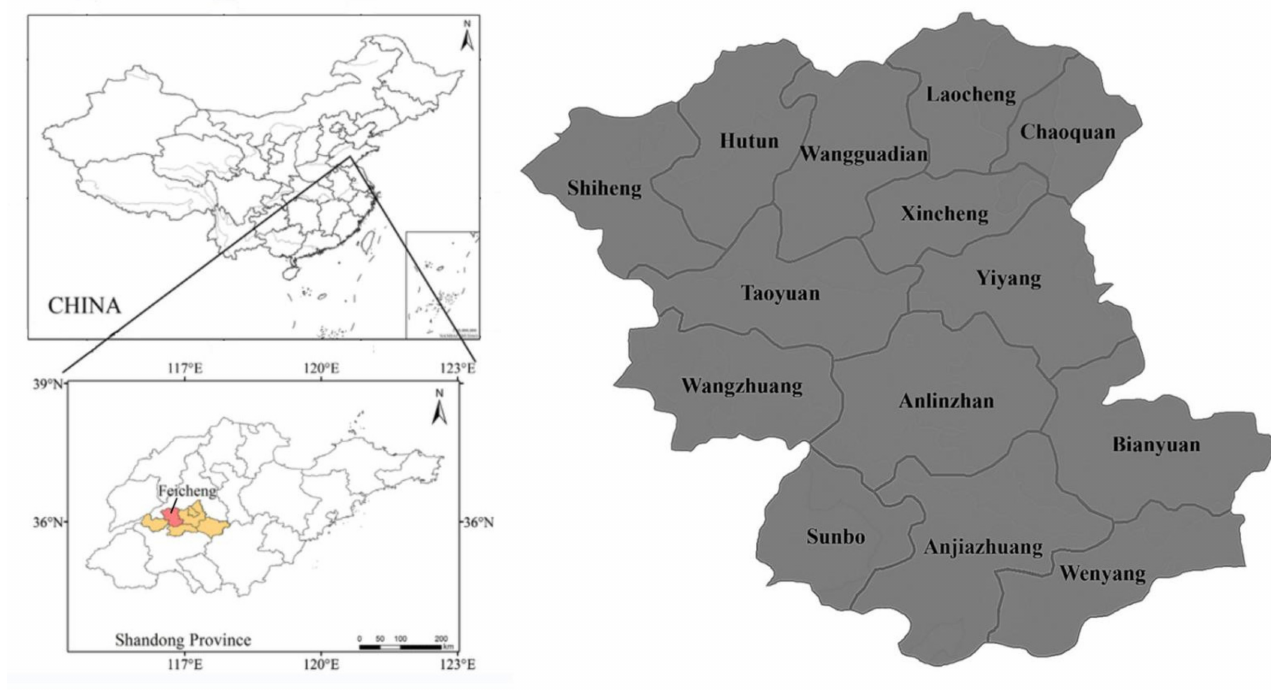
Figure 1. Location map of the study